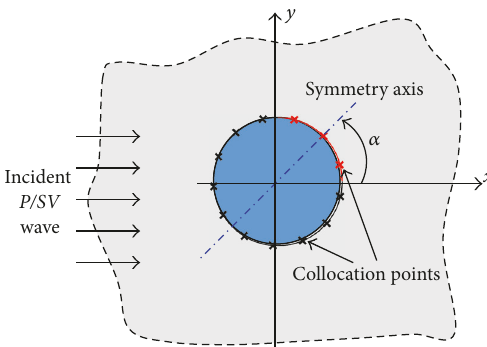
Figure 2: Distribution of CPs denoted by the “ × ” symbol. At least one CP should be distributed on the imperfectly bonded interface as long as 𝛽 is not equal to 0. In this figure, 𝛼 = 𝜋/4 , 𝛽 = 𝜋/2 , and 𝑛 max = 6.